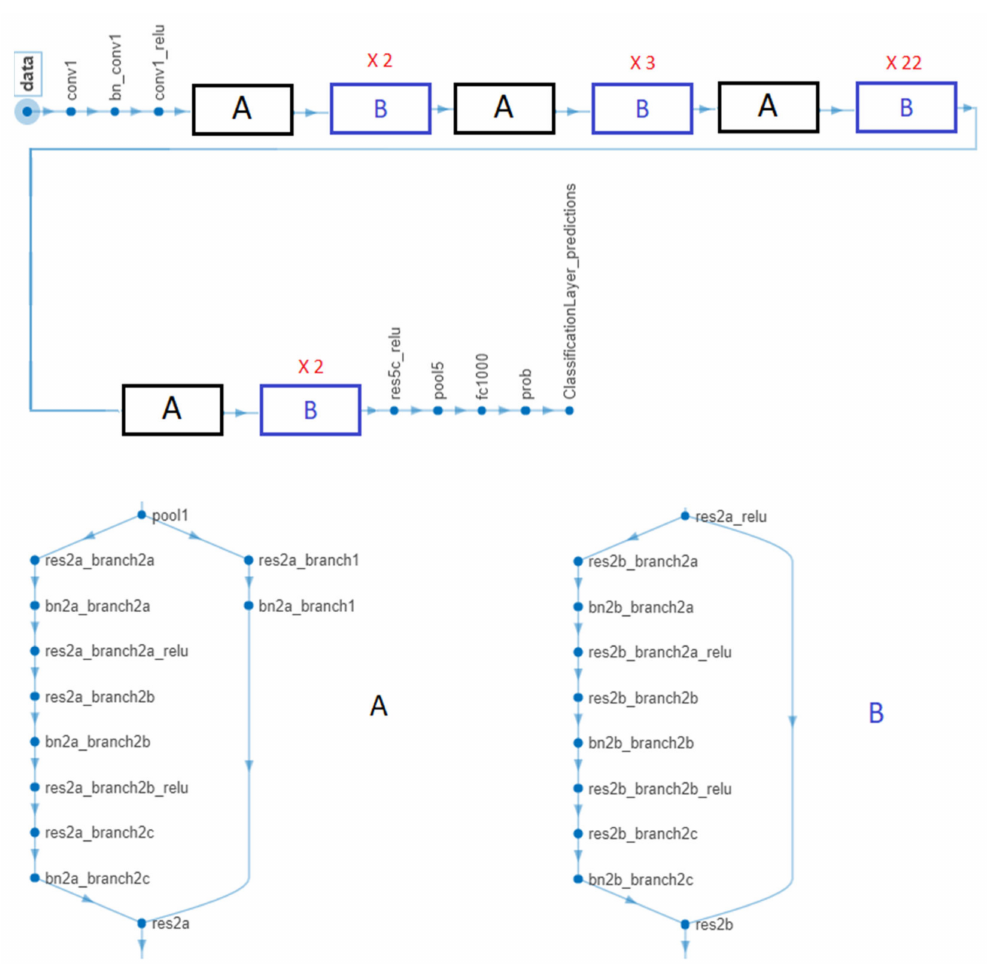
Figure 22. ResNet-101 CNN architecture obtained by the help of